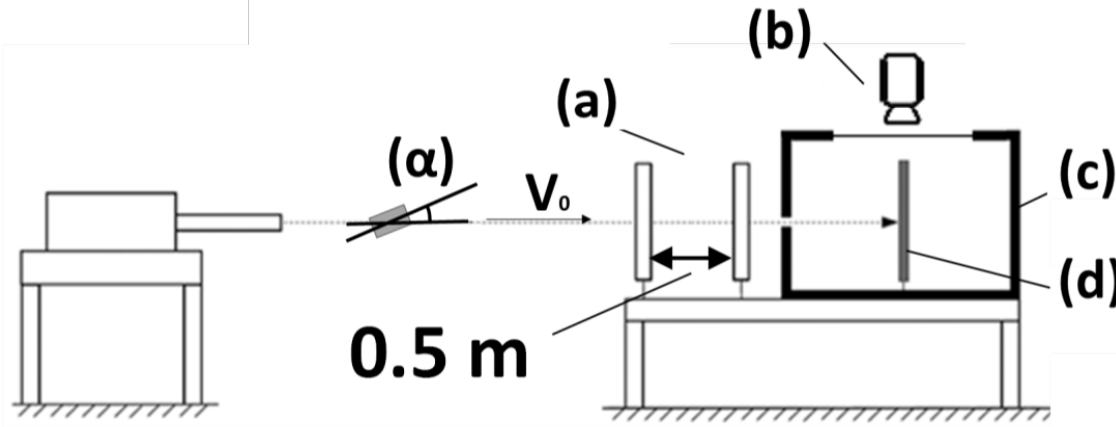
Figure 2. Ballistic experiment schematic set-up: ( a ) light barrier; ( b ) high-speed camera; ( c ) ballistic chamber; ( d ) target; ( α ) impact-pitch angle.